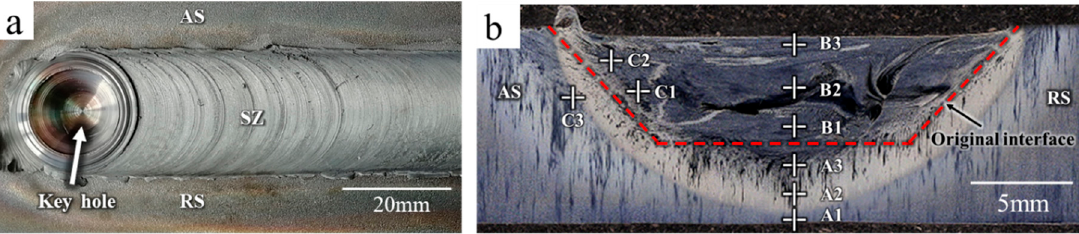
Figure 6. Surface and cross section features of the FSP-repaired samples: ( a ) photo of the repaired sample surface, ( b ) cross-sectional morphology of the repaired sample.